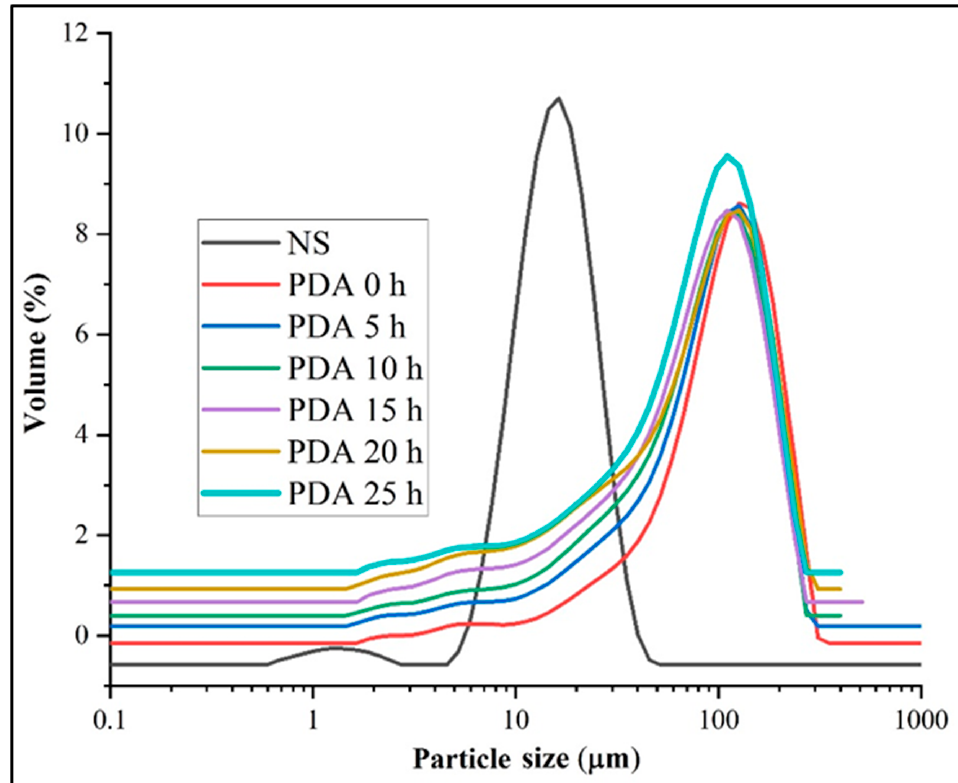
Figure 1. Scanning electron microscopy (SEM) images of native (NS) and debranched in different treatment times combined with autoclaved starches (PDA 0 h, PDA 5 h, PDA 10 h, PDA 15 h, PDA 20 h, and PDA 25 h). The magnification of images was 5000.